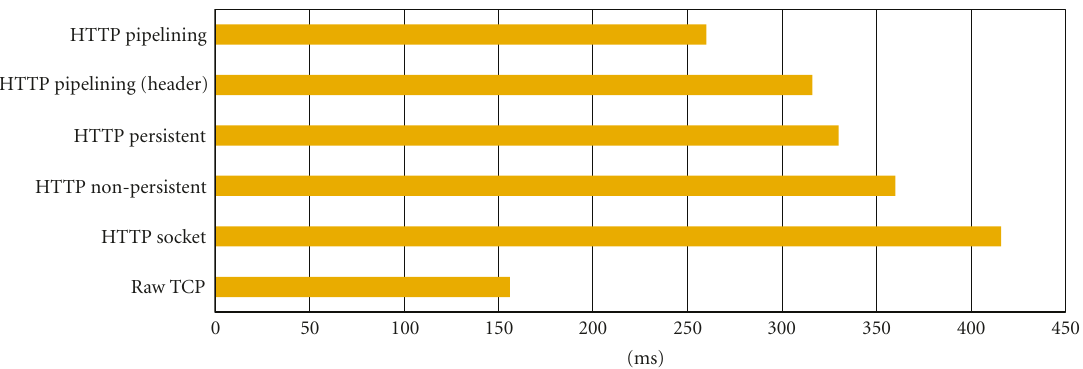
Figure 5: Average round-trip delay time (ms) for di ff erent HTTP clients.